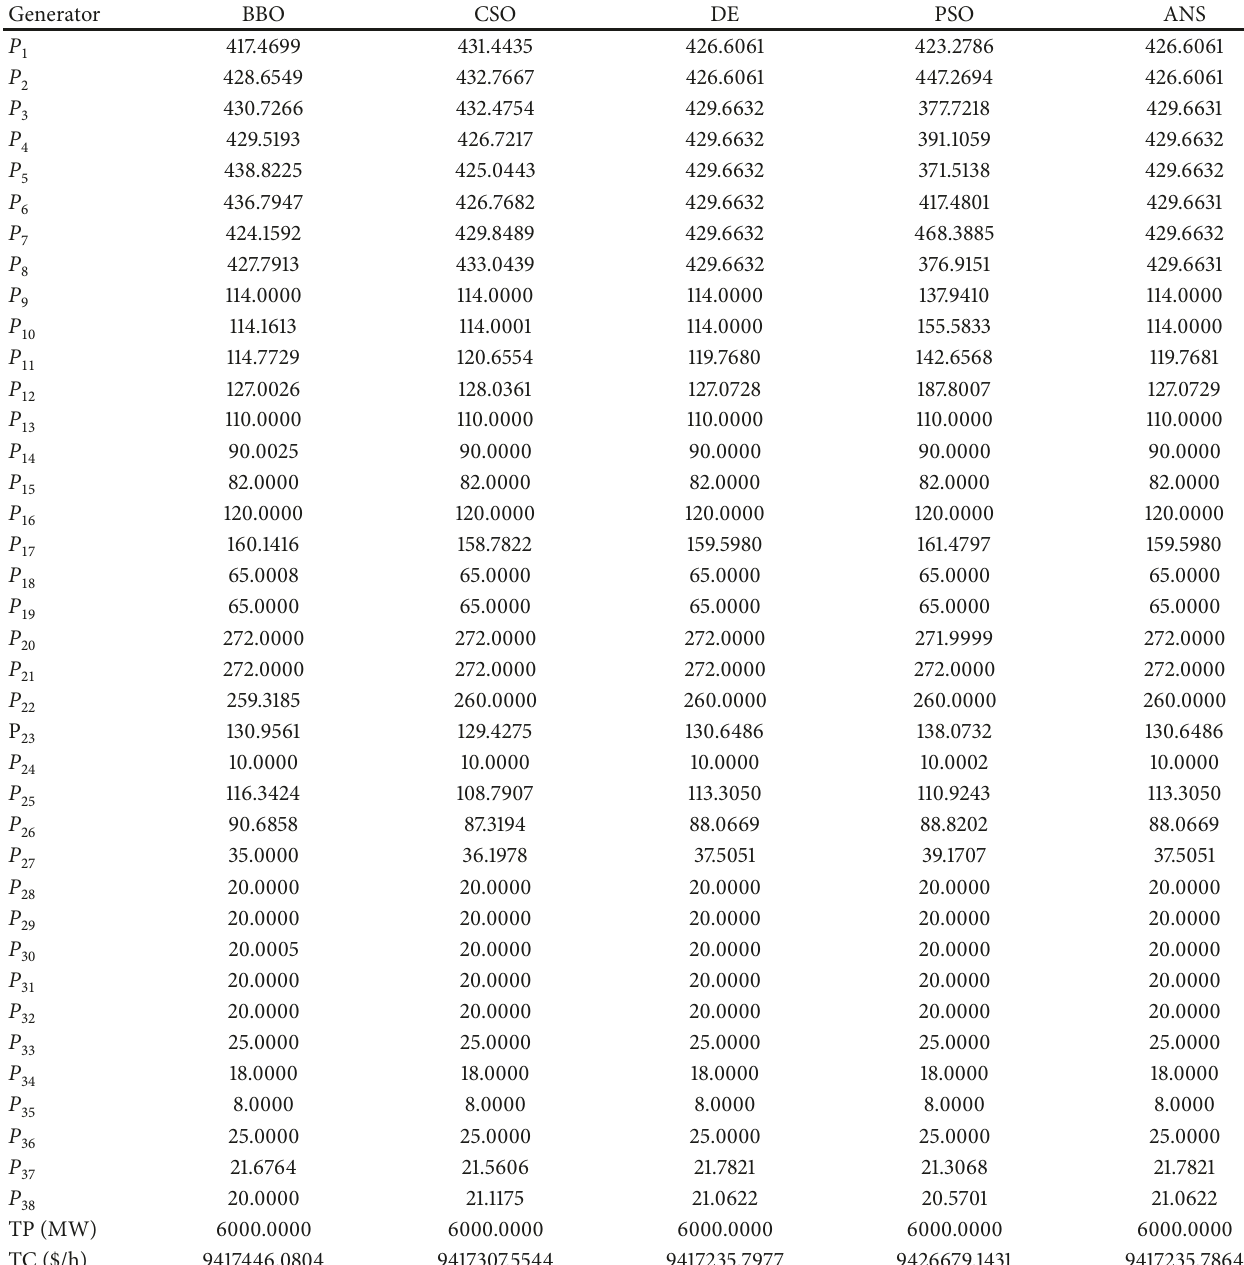
Table 8: Best output power for 38-generator system (Case